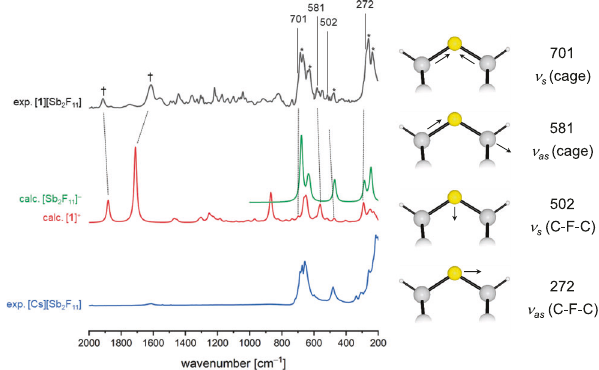
Fig. 3 Vibrational analysis of fl uoronium 1. Left: Experimental infrared spectra of [ 1 ][Sb 2 F 11 ] (black) and [Cs][Sb 2 F 11 ] (blue) at − 40 °C, as well as calculated spectra of cation 1 (red) and anion [Sb 2 F 11 ] − (green) at B3LYP/ def2-TZVPP level of theory. Bands of the anion are denoted with an asterisk in the experimental spectrum and bands associated with the carbonyl group are denoted with a dagger. Right: Approximate representation and assignment of selected C – F – C normal modes of 1 (see text, only displacements involving the C – F – C unit are